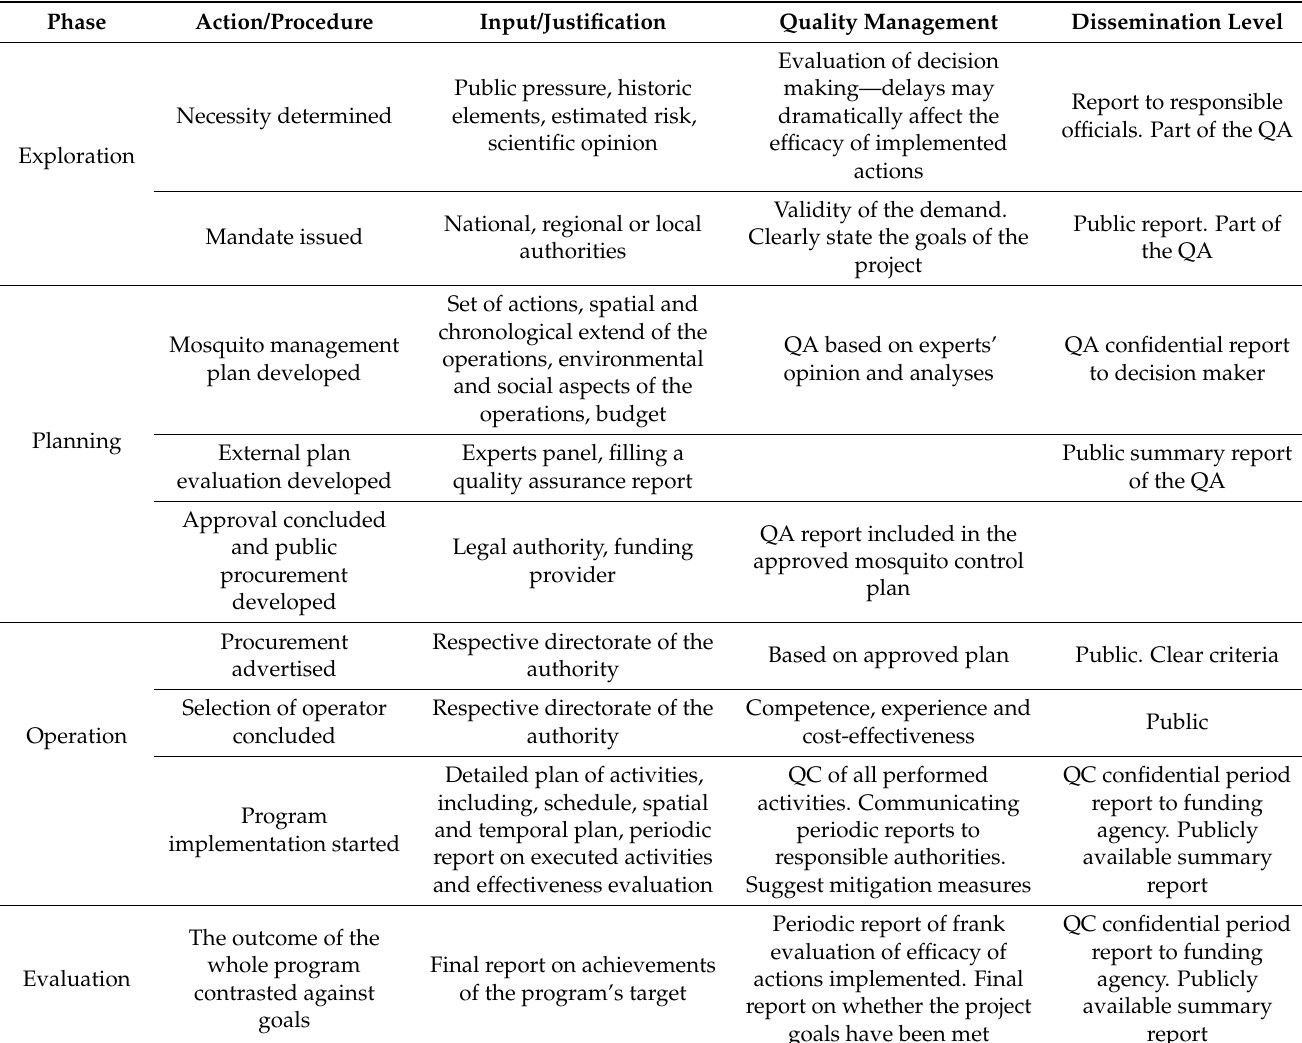
Table 2. A framework for the application of QA and QC in mosquito control programs considering the operational phase, actions and procedures, and dissemination